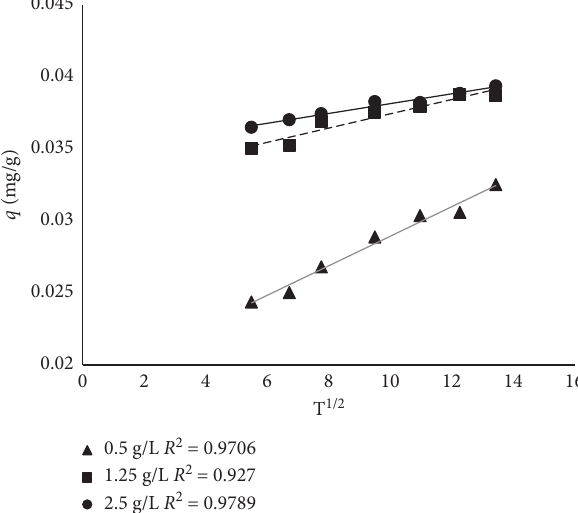
Figure 5: Intraparticle diffusion curve for the MB removal onto Ginkgo biloba leaf